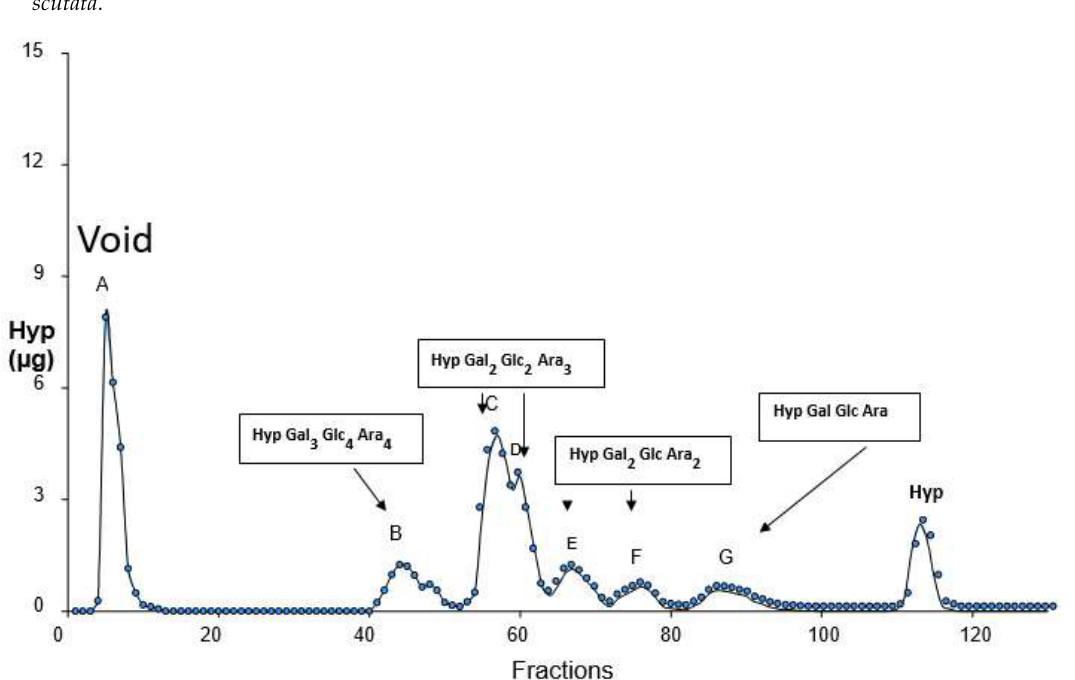
Figure 9. Metaphyte origins. Progression from single cells to filaments that align, forming a flat thallus. The examples here are the biflagellate Chlamydomonas , Spirogyra and the red arrow points to Coleochaete scutata .